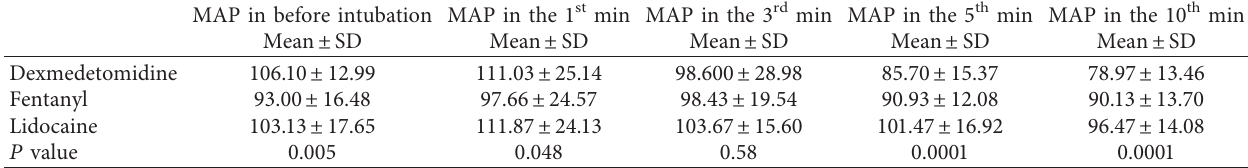
Figure 4: Comparison of DBP in the 1st, 3rd, 5th, and 10th minutes after intubation with before intubation in each group. Table 5: Intergroup comparison of the mean arterial blood pressure (meaningful level P < 0 .